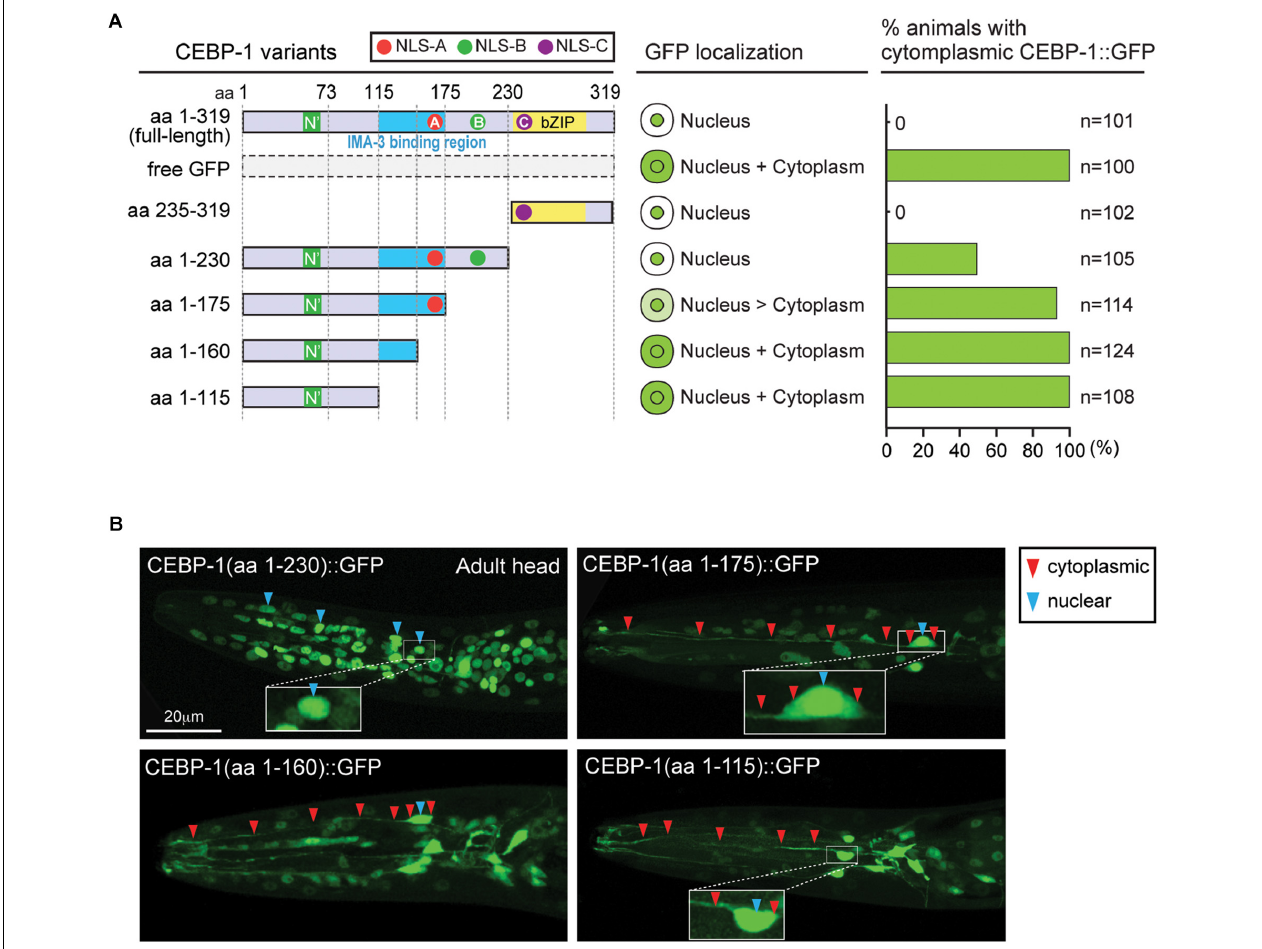
FIGURE 2 | CEBP-1 is localized to the nucleus. (A) Subcellular localization of CEBP-1 variants fused to GFP in C. elegans. (B) Representative confocal images of head parts of adult animals expressing CEBP-1 variants fused to